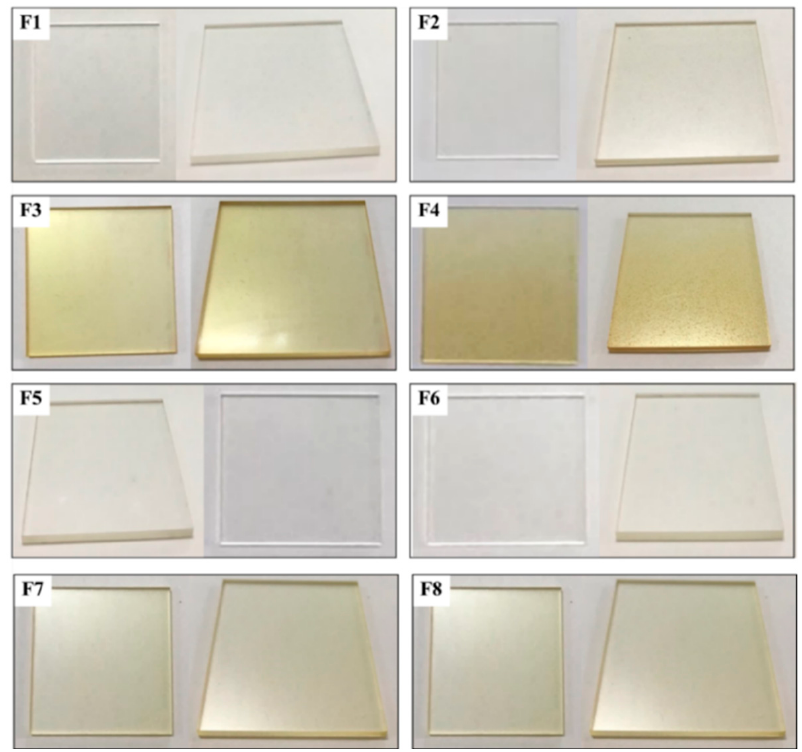
Figure 4. Tested acrylic sheets coated with all eight coating formulas (size 5 × 5 cm 2 .) with EUROX MAX S-710 high pressure spray gun MAX S-710 . MAX S-710 high pressure spray gun MAX